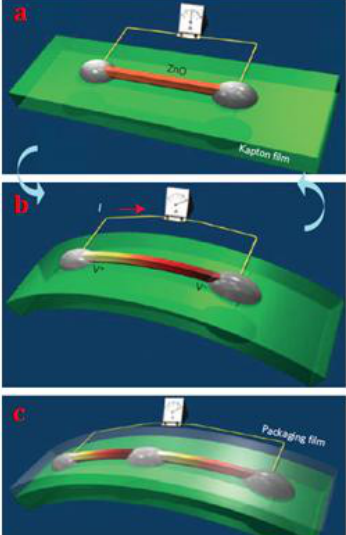
Figure 10. Design of a piezoelectric fine wire (PFW) generator on a flexible substrate [50] (Reprinted with permission from Macmillan Publishers